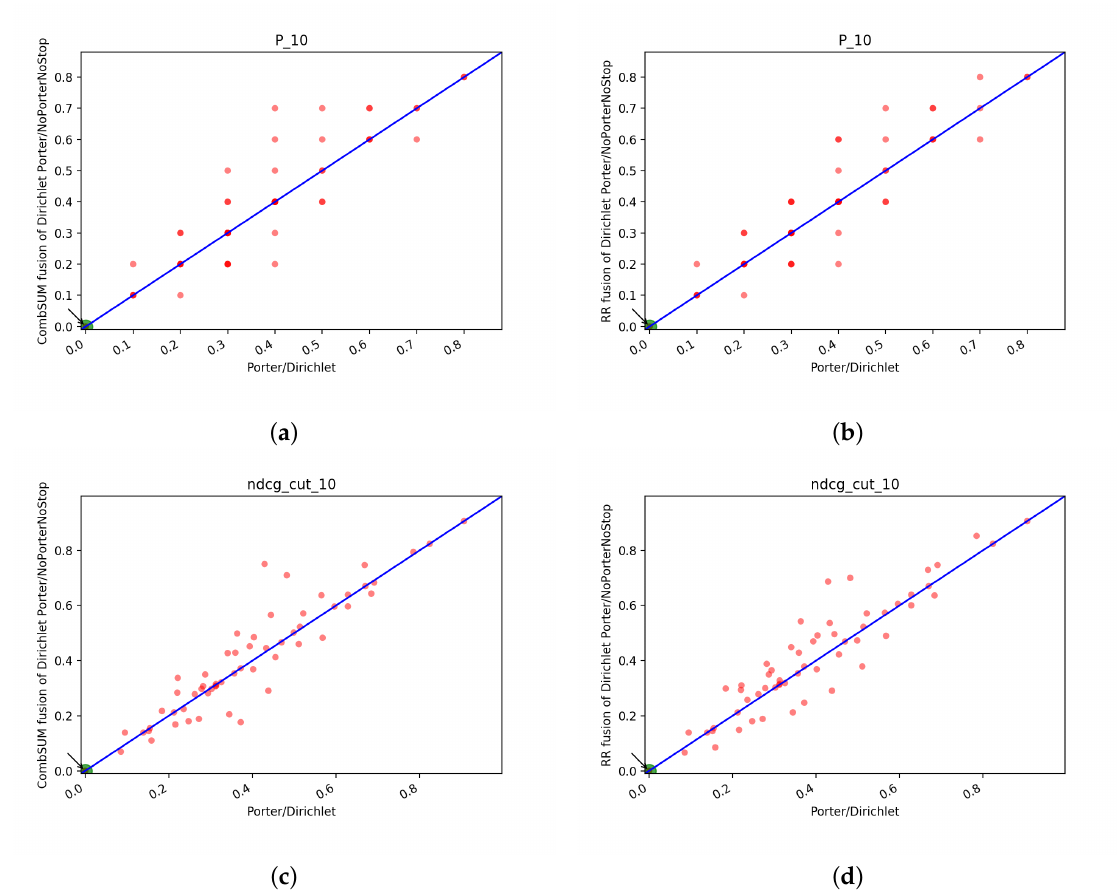
Figure 25. T1: scatter plots of the best run vs. the fusion of the two best runs: ( a ) P@10 for Porter/Dirichlet vs. CombSUM, ( b ) P@10 for Porter/Dirichlet vs. RR, ( c ) NDCG@10 for Porter/Dirichlet vs. CombSUM, ( d ) NDCG@10 for Porter/Dirichlet vs.